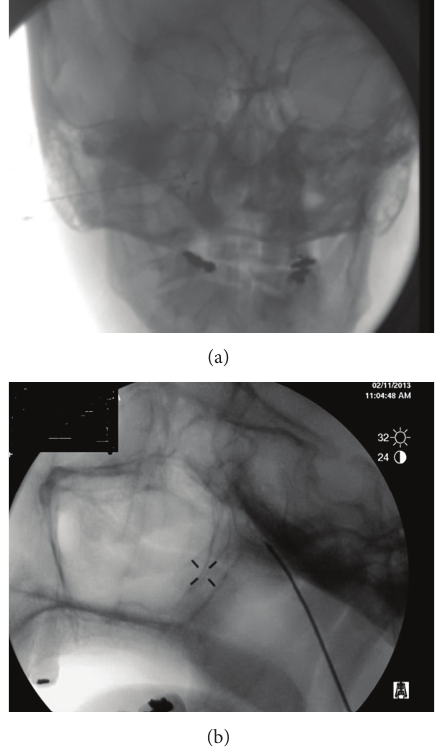
Figure 3: Anteroposterior view X-ray (a) and lateral X-ray (b) show the final radiofrequency needle position at the sphenopalatine fossa.